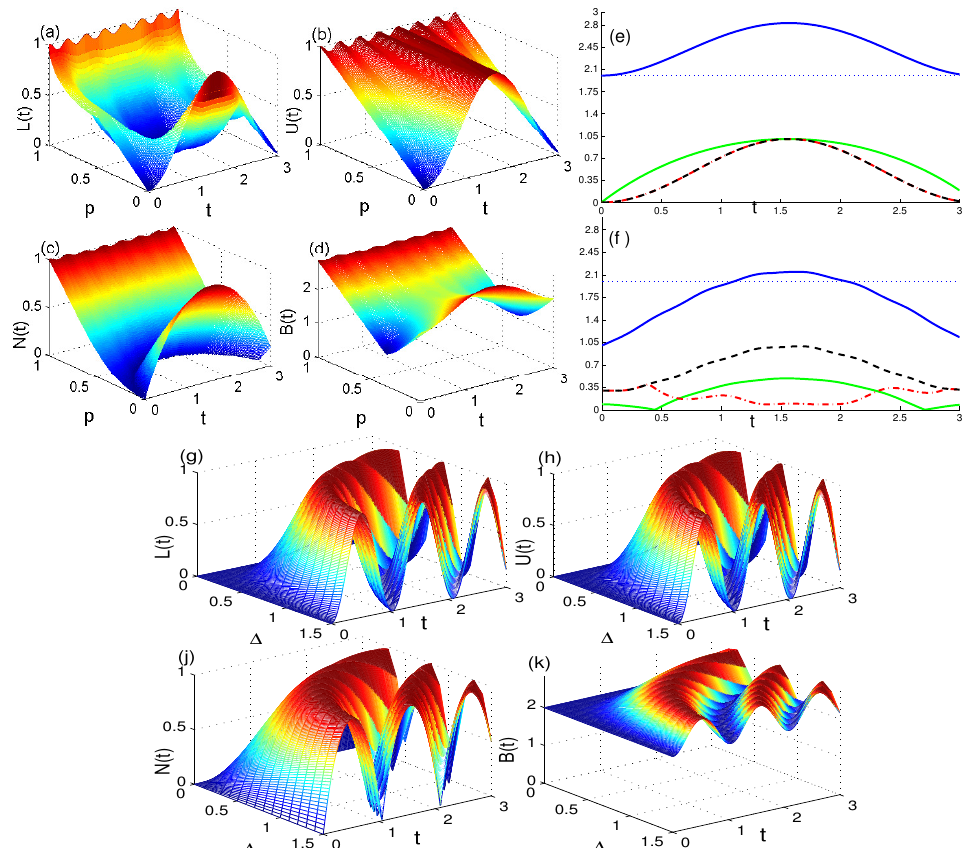
Figure 3. The 3D-evolution of L ( t ) in ( a ), U ( t ) in ( b ), N ( t ) in ( c ) and B ( t ) in ( d ) when J x = J z = 2, χ z = 0.5 and γ = 0 for the cases: p ∈ [ 0,1 ] with ∆ = 0.5 in (a,b), and ∆ ∈ [ 0,1.5 ] with p = 0 in ( g – k ). The 2D-evolution of L ( t ) (dashed plots), U ( t ) (dashed dotted plots), B ( t ) (upper solid plots) and N ( t ) (solid plots) for p = 0 in ( e ) and p = 0.3 in ( f